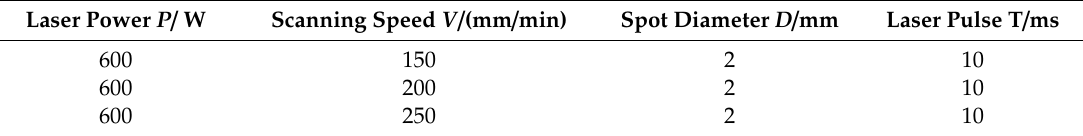
Figure 1. Schematic diagram of laser remelting. Table 3. Parameters of laser remelting